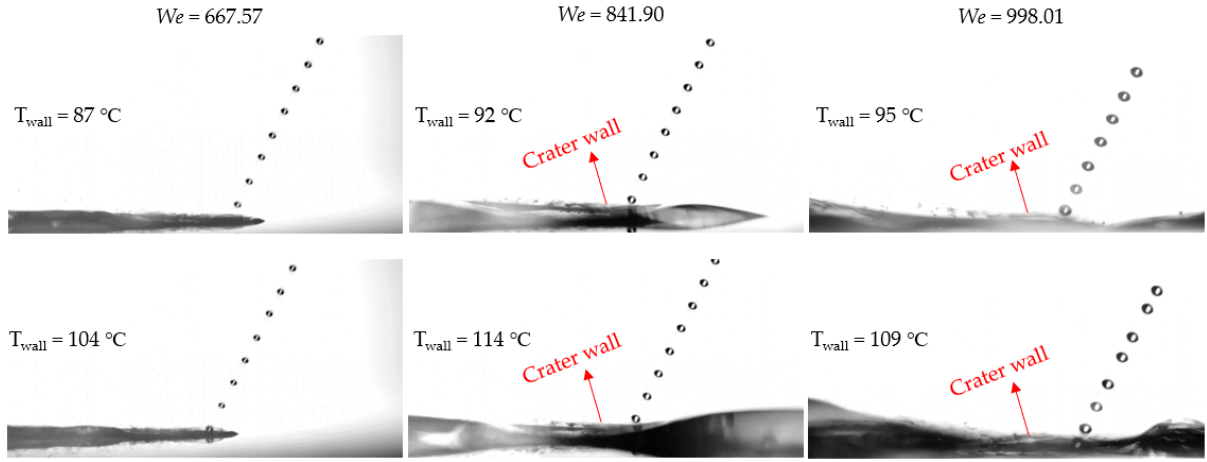
Figure 3. Steady-state hydrodynamic patterns of ethanol droplet train impingement on the target glass surface at different Weber numbers for the surface temperature values of 85.00 °C to 115.00 °C.